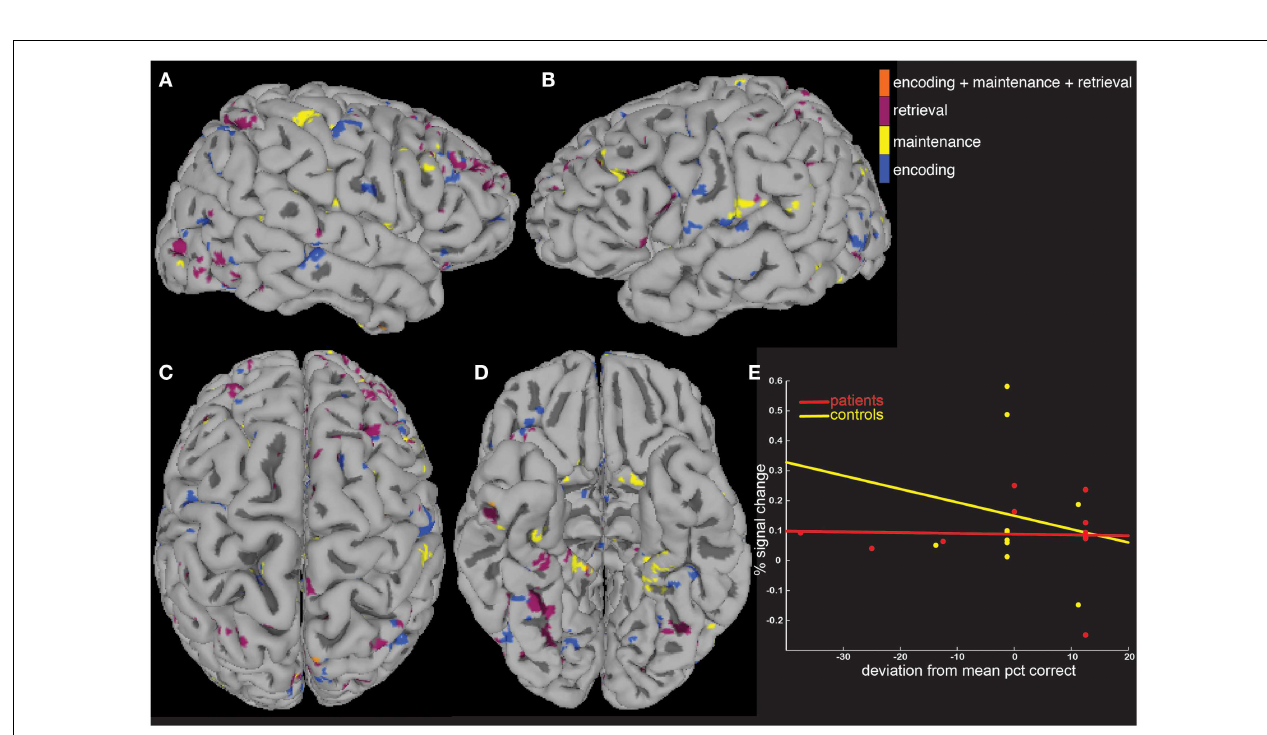
FIGURE 4 |A covariate interaction analysis shows regions that differ as a function of age . Several regions (A–D) exhibited fMRI activity that covaried significantly ( p < 0.05) differently between patients and controls as a function of age (E) .